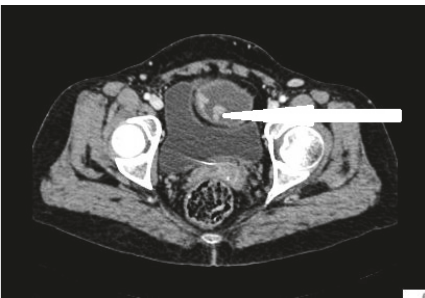
Figure 5: High power view of tumor cells showing cytoplasmic and membranous positivity for Uroplakin II (IHC 40X